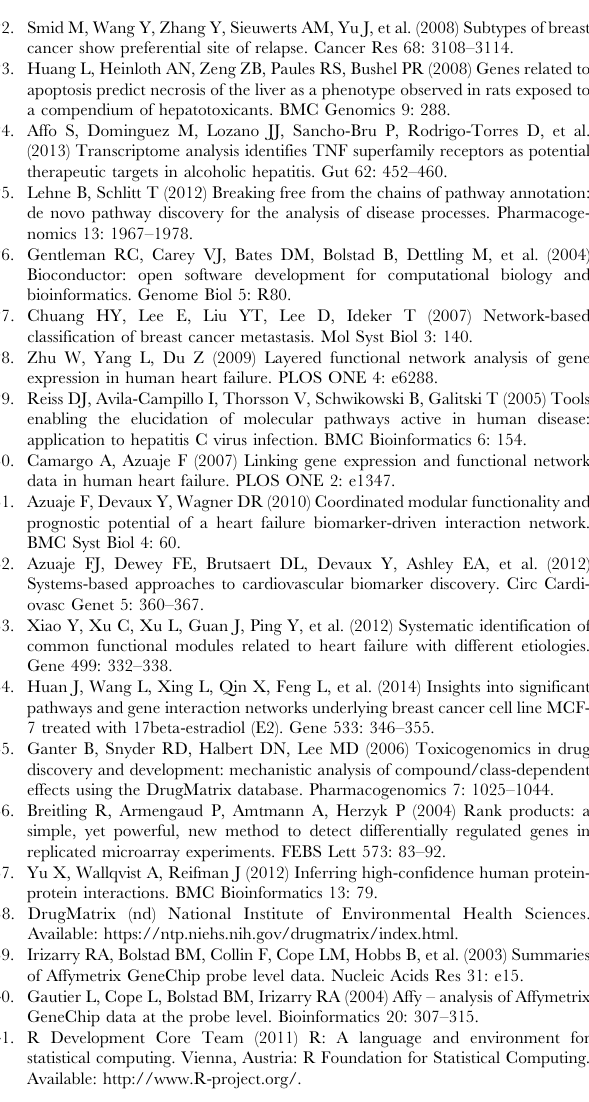
Table S8 List of 126 experimental liver cirrhosis- relevant genes collected from the Comparative Toxico- genomics Database (CTD). (XLSX) Table S9 List of enriched gene ontology (GO) terms for the protein-protein interaction (PPI) network modules, M1-M11. (XLSX) Data S1 Cytoscape session file associated with network module generation. The Cytoscape session file includes 1) high-confidence human PPI network data, 2) the liver fibrosis- relevant parent sub-network, and 3) 11 modules obtained by clustering the liver fibrosis-relevant parent sub-network. (ZIP) Data S2 KeyPathwayMiner input gene list. (XLSX) Data S3 Cytoscape session file associated with genera- tion of the liver fibrosis-relevant parent sub-network. The Cytoscape session file includes 1) four sub-networks obtained